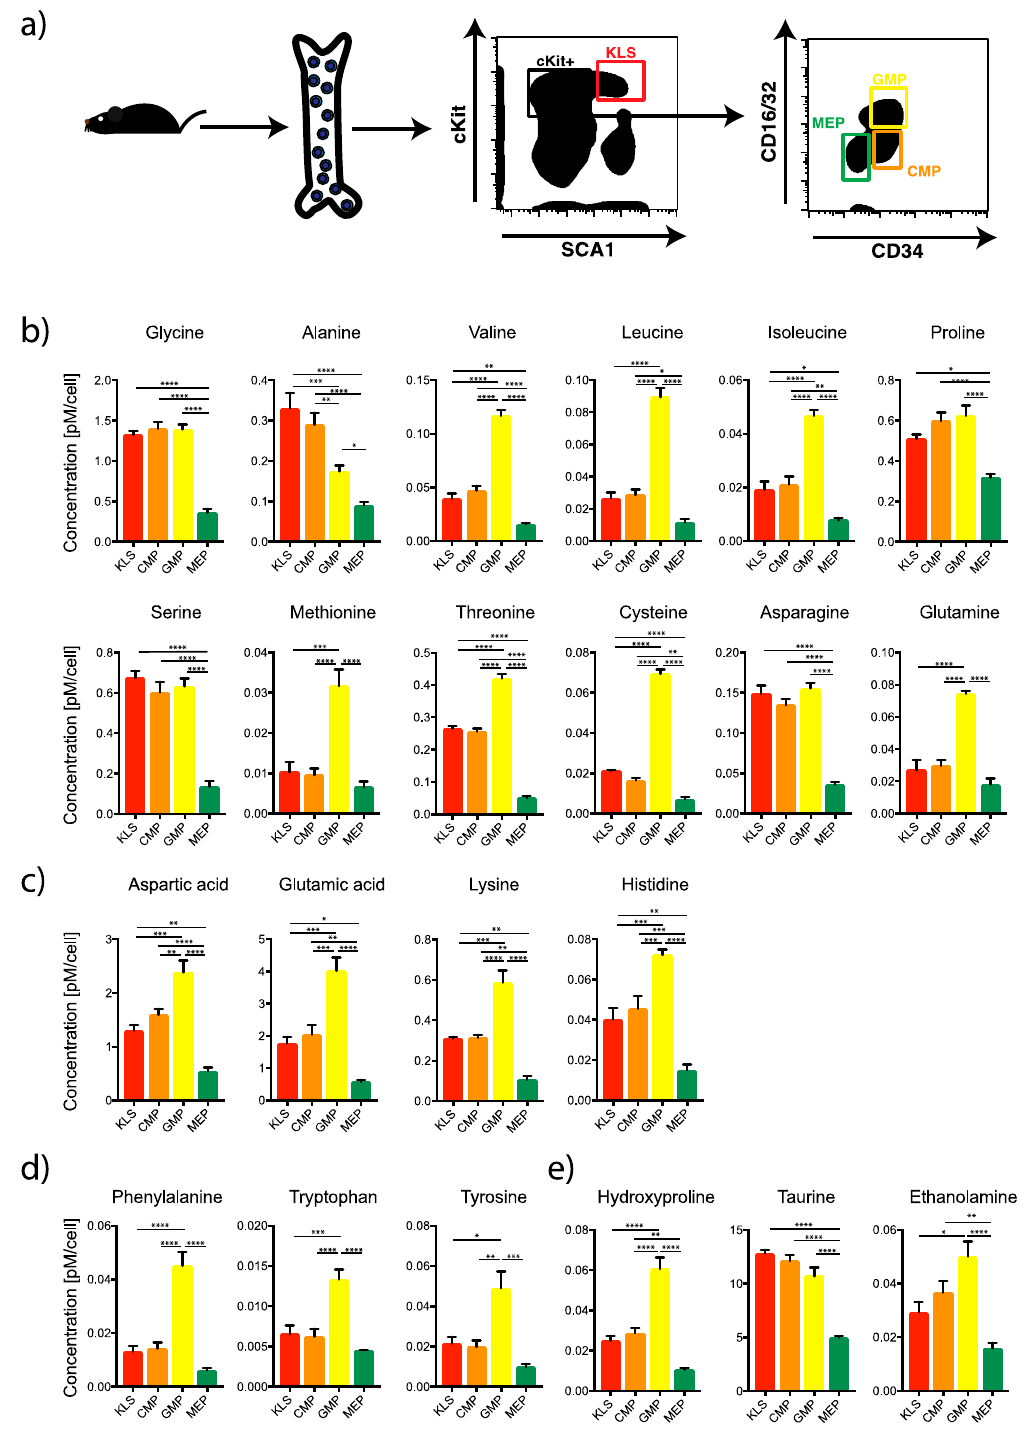
Figure 1. Estimation of amino acid content in various bone marrow populations. ( a ) Different populations from the mouse BM were FACS sorted for amino acid analysis. KLS: Lin − cKit + Sca1 + ; CMP: Common Myeloid Progenitor; GMP: Granulocyte Macrophage Progenitor; MEP: Megakaryocyte Erythroid Progenitor. ( b – e ) Measurement of amino acid content in different populations. One-way ANOVA * p < 0.05, ** p < 0.01, *** p < 0.001, **** p < 0.0001 ( n = 3).